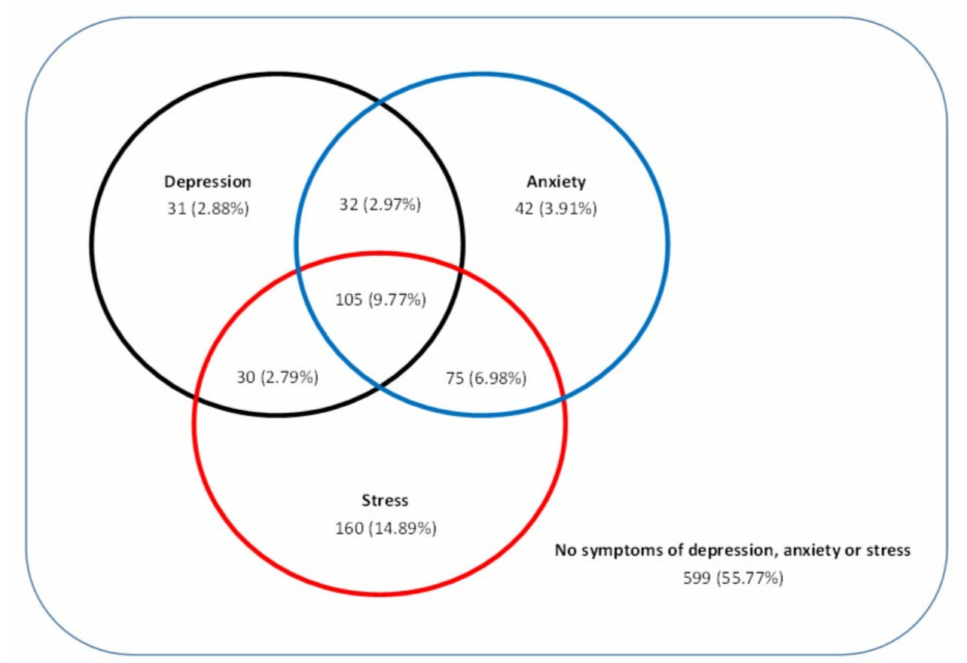
Figure 1. Coexistence of symptoms of depression, anxiety and stress according to the results from DASS-21 ( n =